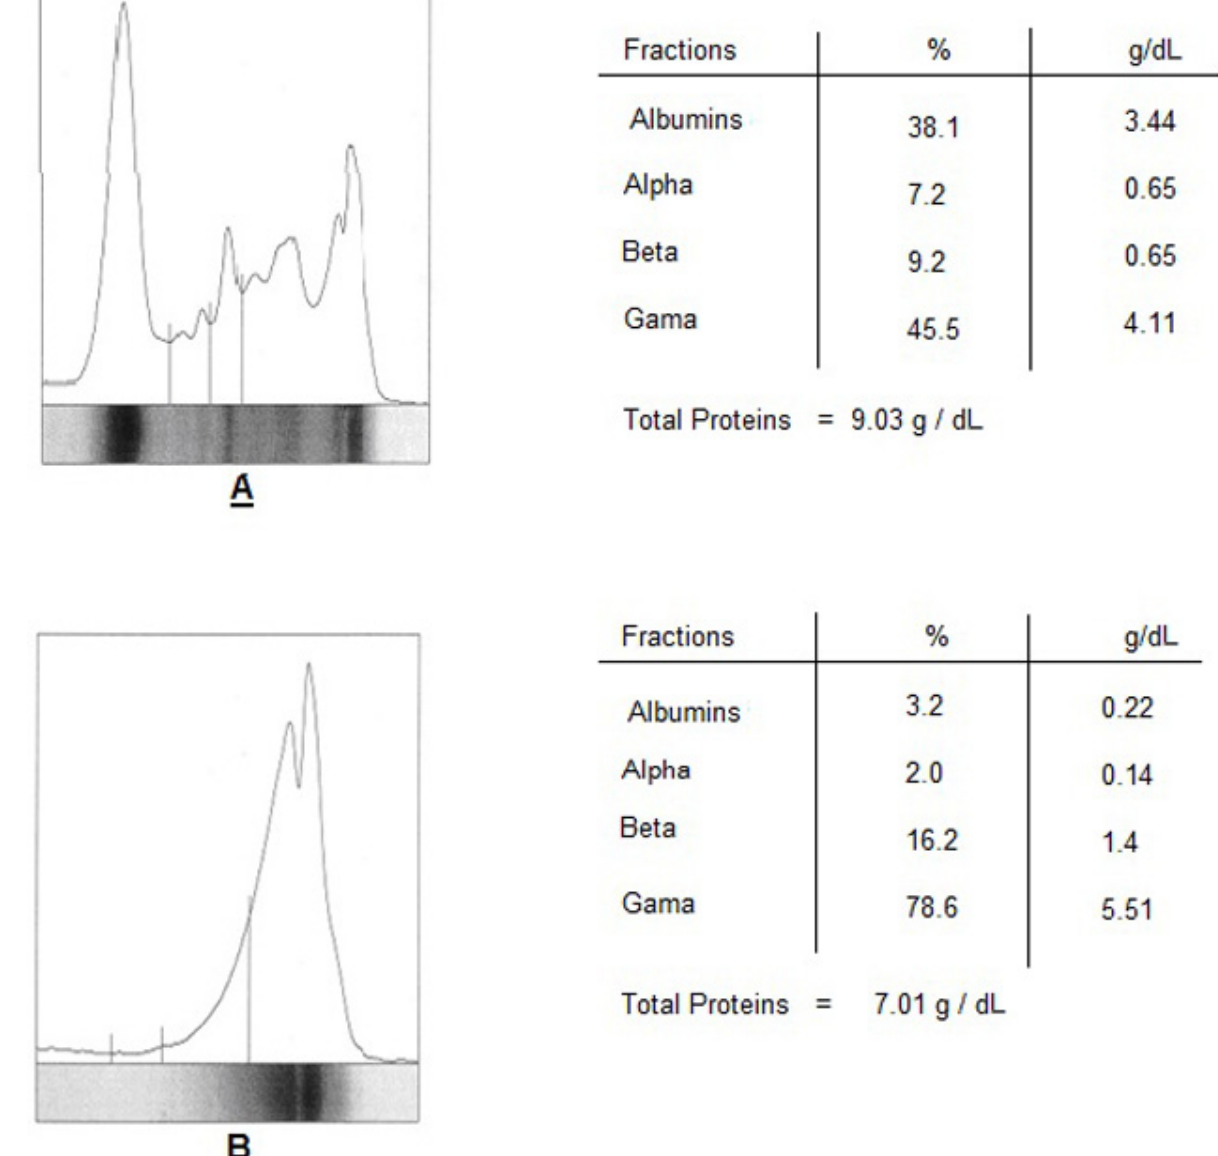
Figure 6. Electrophoresis profile of ( A ) serum and ( B ) purified plasma containing the F(ab’) results was made by software (SDS CELM 60 – software for densitometry